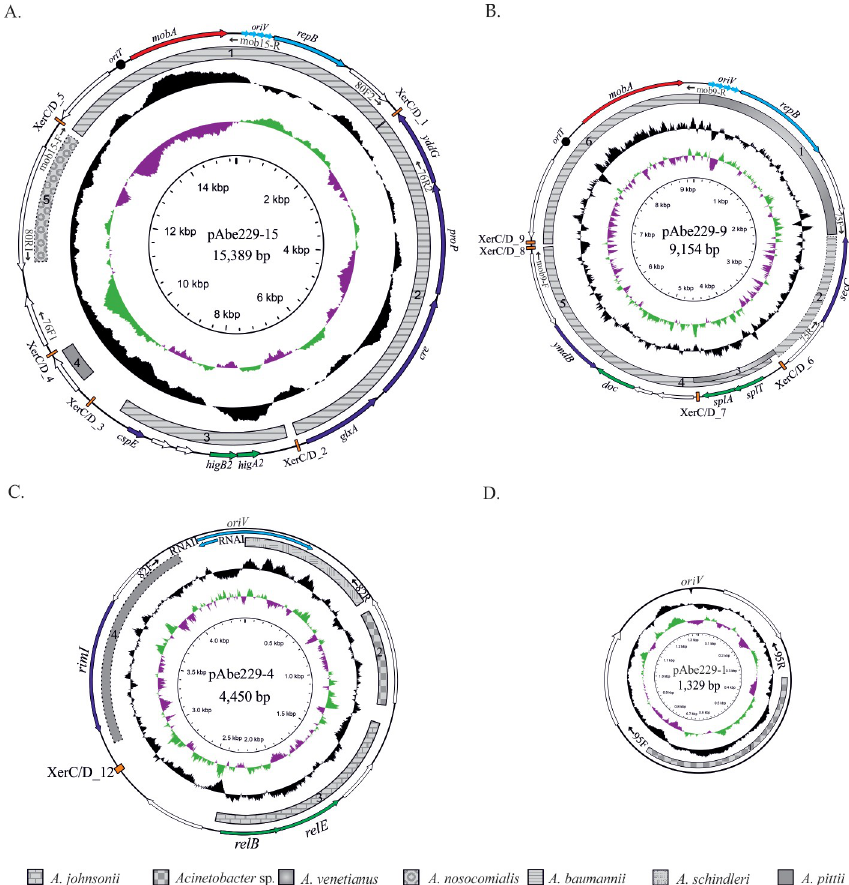
Fig 2. Schematic representation of plasmids pAbe229-15 (A), pAbe229-9 (B), pAbe229-4 (C) and pAbe229-1 (D). The regions encoding RNAI- and RNAII-homologous sequences in pAbe229-4 are highlighted in light blue, and the direction of transcription is also indicated in each case. In pAbe229-1, the dark triangle denotes a high-AT region (putative oriV ) predicted on the basis of the cumulative GCskew (see the text). Plasmids are not drawn to scale. For details, see the legend to Fig